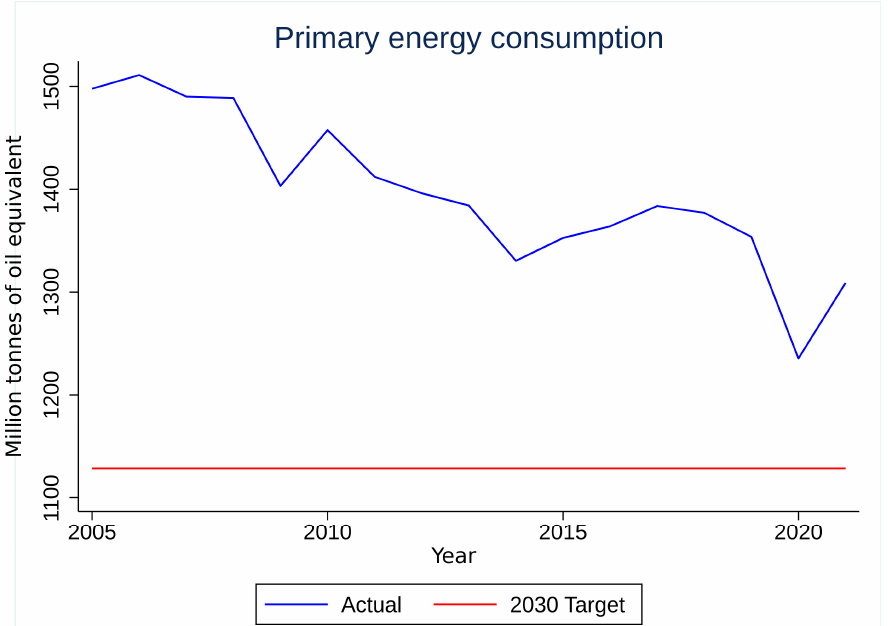
Figure 3. European Union’s primary energy consumption with regard to 2030 goals. Source: Own elaboration based on public data available at EuroStat. The data were accessed on 4 February 2022 from https://ec.europa.eu/eurostat/web/main/data/database.